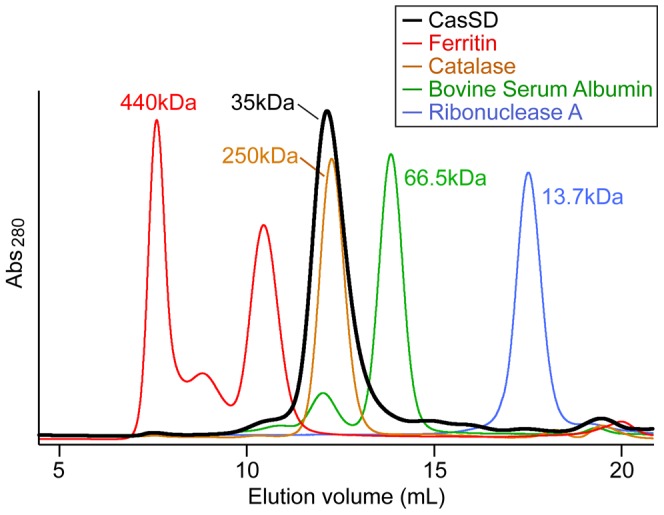
Characterization of CasSD by analytical size-exclusion chromatography.Purified CasSD was subjected to an analytical size-exclusion chromatography. Sample buffer and running buffer used were 10 mM potassium phosphate at pH 7.5, 100 mM potassium chloride, 1 mM EDTA and 5% (v/v) glycerol. Reference proteins were also subjected to the same chromatographic treatment for comparison. Red: ferritin; orange: catalase tetramer; green: bovine serum albumin; blue: ribonuclease A. Ferritin assumes a 440-kDa complex comprised of 24 subunits of light and heavy chains. Peaks eluting at a higher elution volume are thought to be ferritin molecules comprised of fewer subunits.